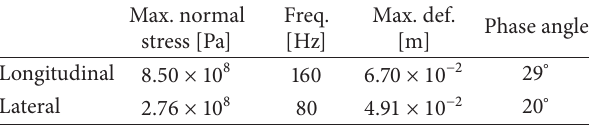
Table 3: Harmonic analysis